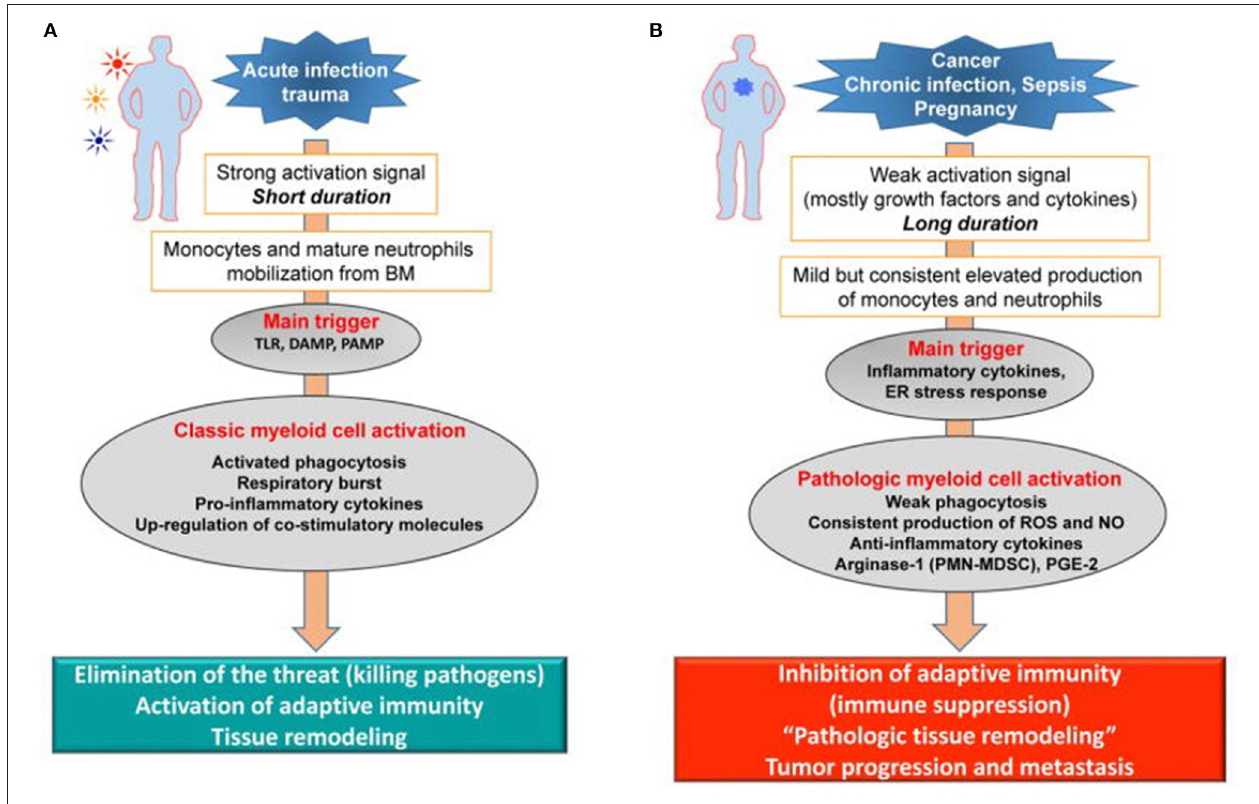
FIGURE 2 | Pathologic activation of neutrophils and monocytes. (A) In the presence of strong activation signals coming from pathogens in the form of toll-like receptors ligands (TLRL), damage associated molecular pattern (DAMP), pathogen-associated molecular patterns (PAMP) molecules monocytes and neutrophils are mobilized from the BM. This response results in classic myeloid cell activation. (B) In the presence of weak activation signal mediated mostly by growth factors and cytokines, myeloid cells undergo modest but continuous expansion. Pro-inflammatory cytokines and ER stress responses contribute to pathologic myeloid cells activation that manifests in weak phagocytic activity, increased production of reactive oxygen species (ROS), nitric oxide (NO), arginase 1 (not expressed in human monocytes and M-MDSC) and prostaglandin-E2 (PGE2). This results in immune suppression. Endoplasmic reticulum = ER. Modified from Veglia et al. (